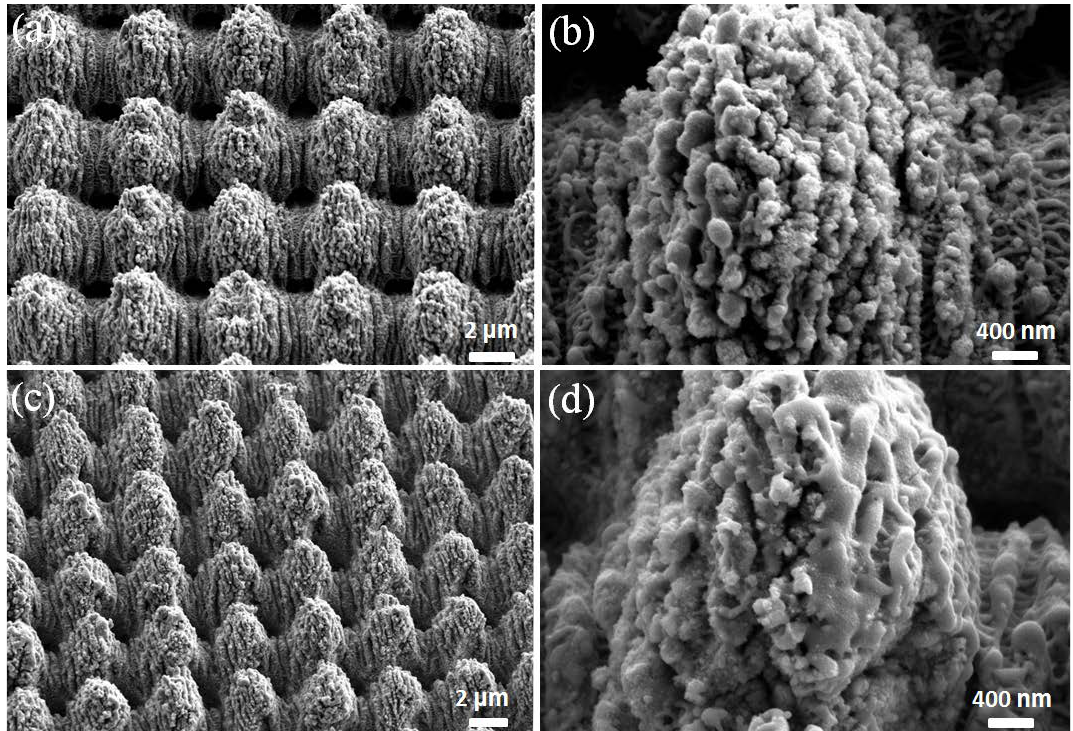
Figure 6. Pillar-like structures fabricated by Direct Laser Interference Patterning on ( a , b ) ferritic steel and ( c , d ) Ti6Al4V substrates. The selected spatial period was 5.2 µm. For the process, the laser fluence was fixed to 1.42 J/cm 2 and a pulse-to-pulse overlap of 99% was used.